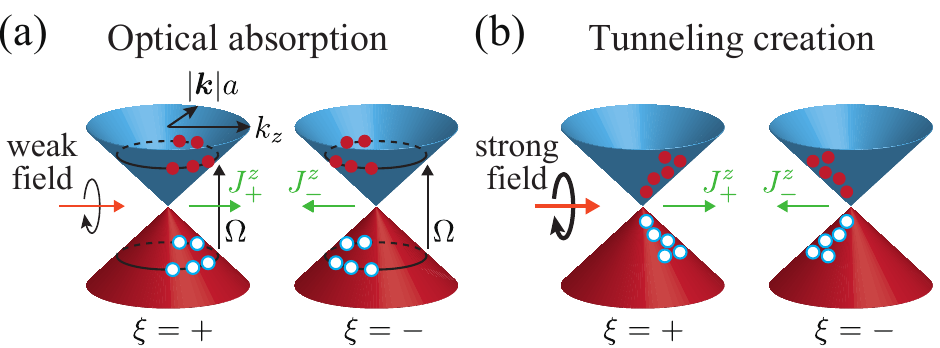
Figure 6: Nonadiabatic versus Perturbative photo-current generation in 3D massless Dirac fermion: Schematics of pair production and resulting photocurrent in the two Weyl components induced by the (a) tunneling creation and (b) optical excitations. (a) In tunneling creation, the pairs are produced according to Eq. (29). See Fig. 7 for the results. (b) In optical absorption, the pairs are concentrated on equal energy curves due to energy